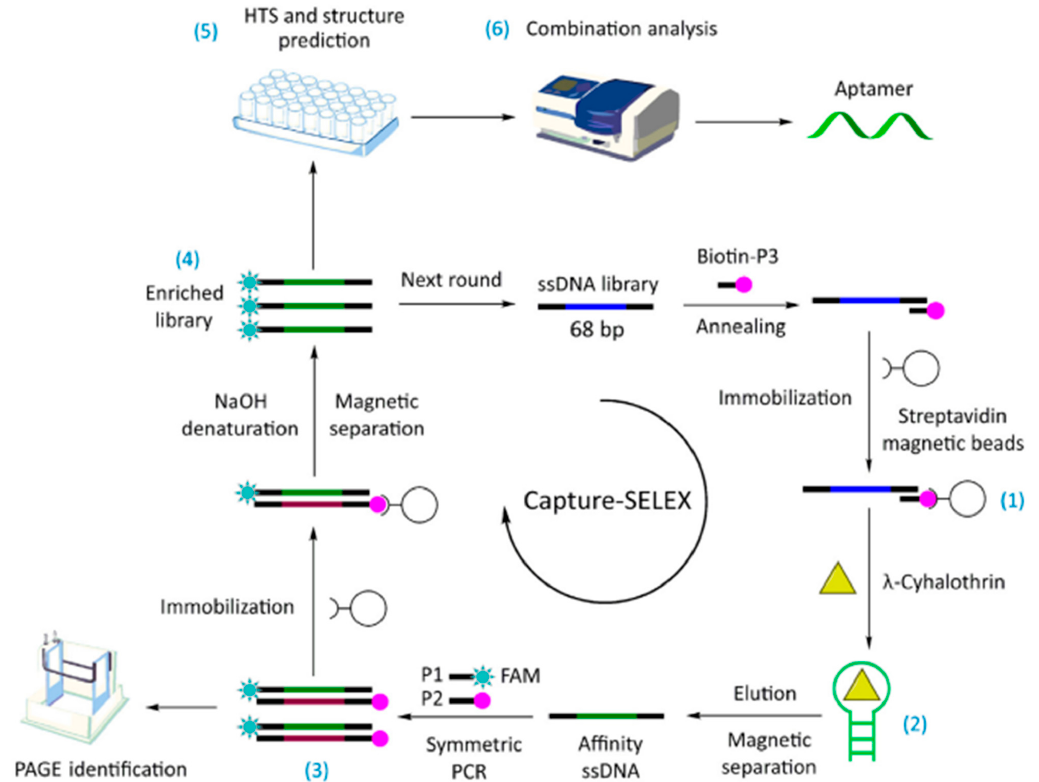
Figure 2. The capture-SELEX technology roadmap for screening aptamers bound to l-cyhalothrin ([48]). (1 Immobilization of random ssDNA library; 2 Elution of affinity ssDNA sequences; 3 Symmetric PCR amplification and electrophoresis identification; 4 Preparation of ssDNA enrichment library; 5 High-Throughput Sequencing (HTS) and secondary structure prediction; 6 Binding characteristics of affinity sequences).